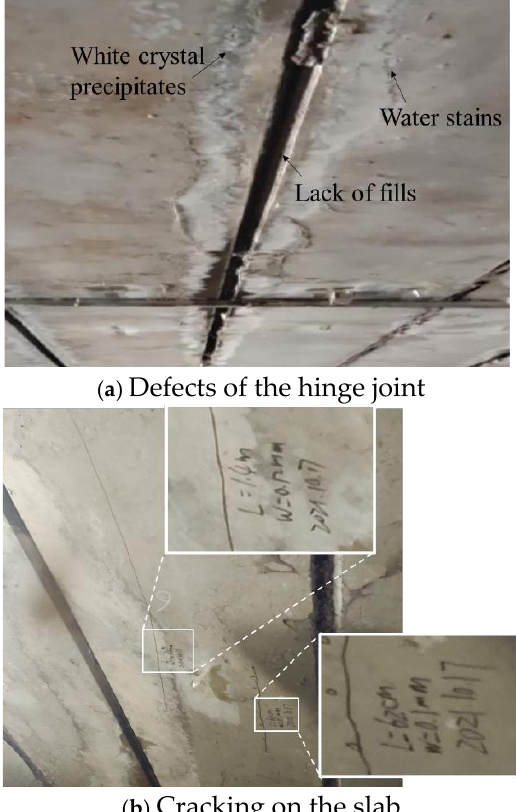
Figure 4. Damage status of the hollow slab bridge.